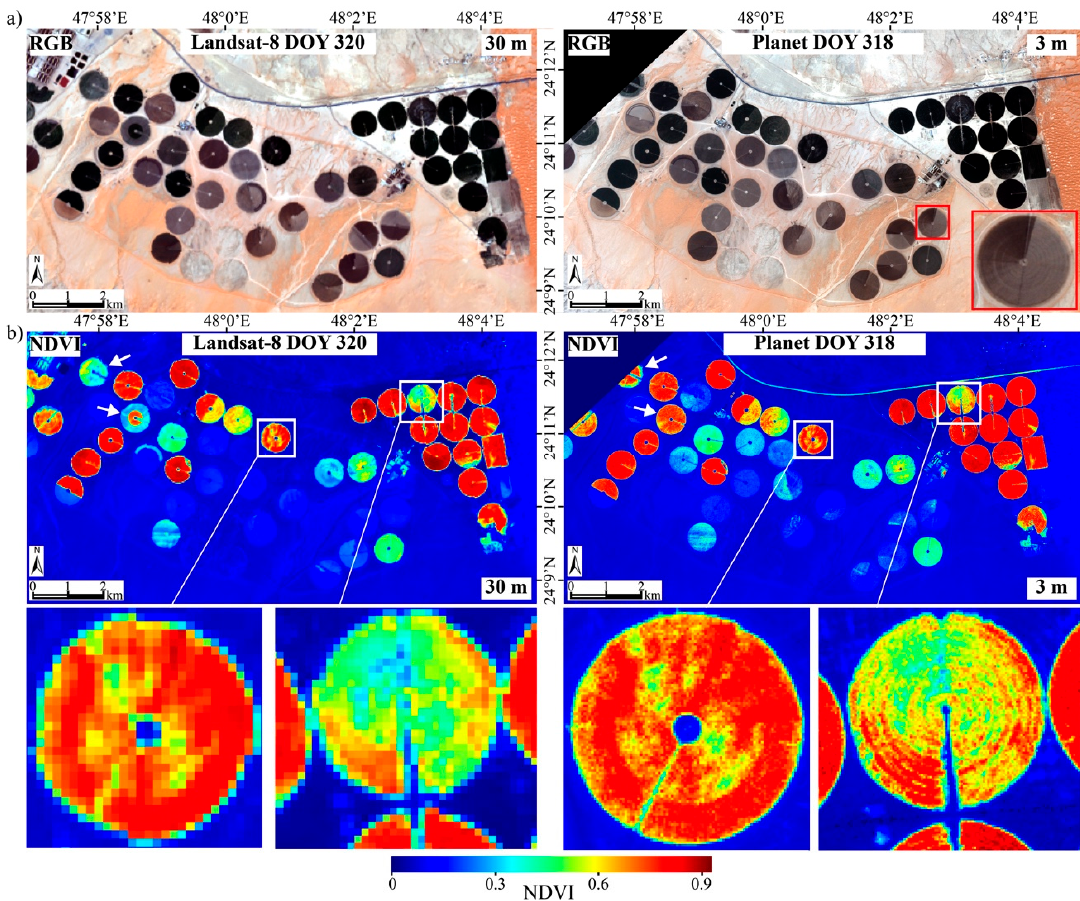
Figure 2. ( a ) True color RGB imagery from Landsat-8 and Planet acquisitions two days apart. The insert in the Planet image is included to demonstrate the impact of pivot irrigation on the RGB signal. ( b ) Intercomparison of Landsat-8 NDVI and Planet NDVI computed from RGB imagery using Cubist regressions generated on the basis of Landsat-8 training data from DOY 320. The two white arrows highlight fields that have undergone significant change in cover conditions between the two acquisitions. Zoomed images are included to demonstrate the enhanced spatial detail achievable with Planet data.